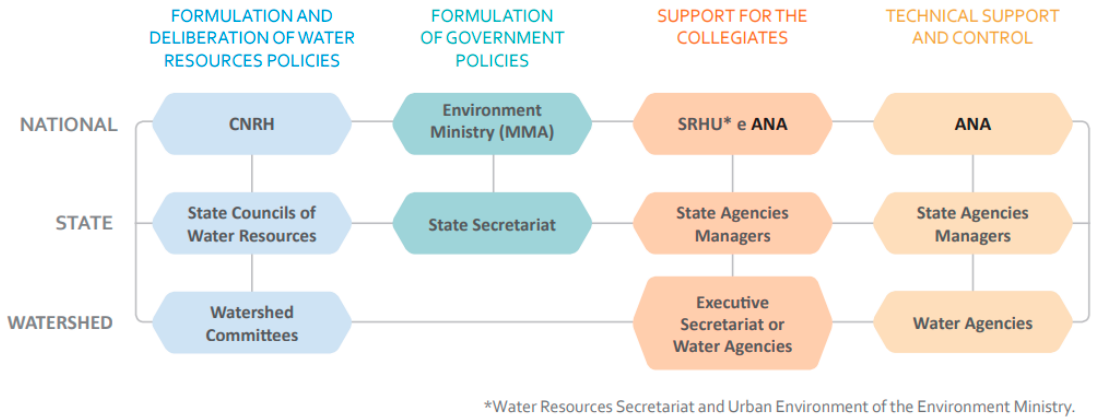
Figure1. Organizationofthe NationalSystemof WaterResourcesManagementand thestatesystems Figure 1. Organization of the National System of Water Resources Management and the state systems [6].